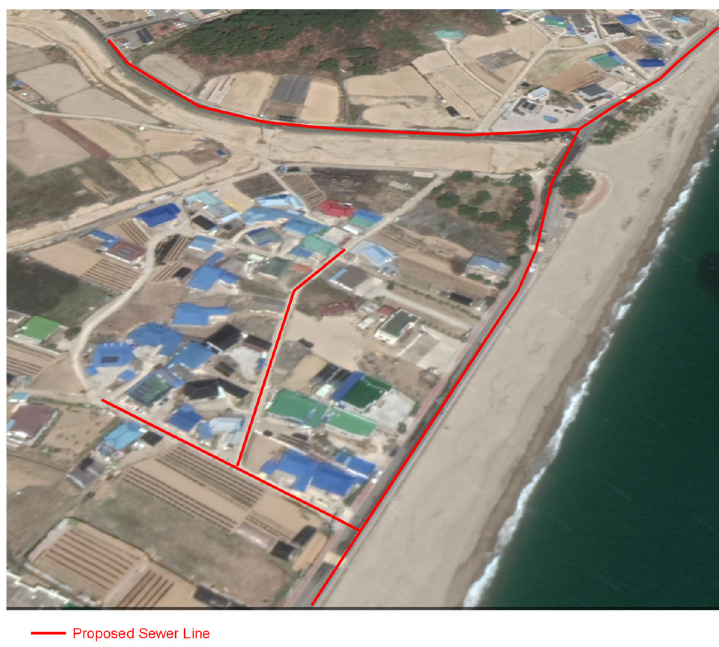
Figure 9. Project overview with proposed new design line.